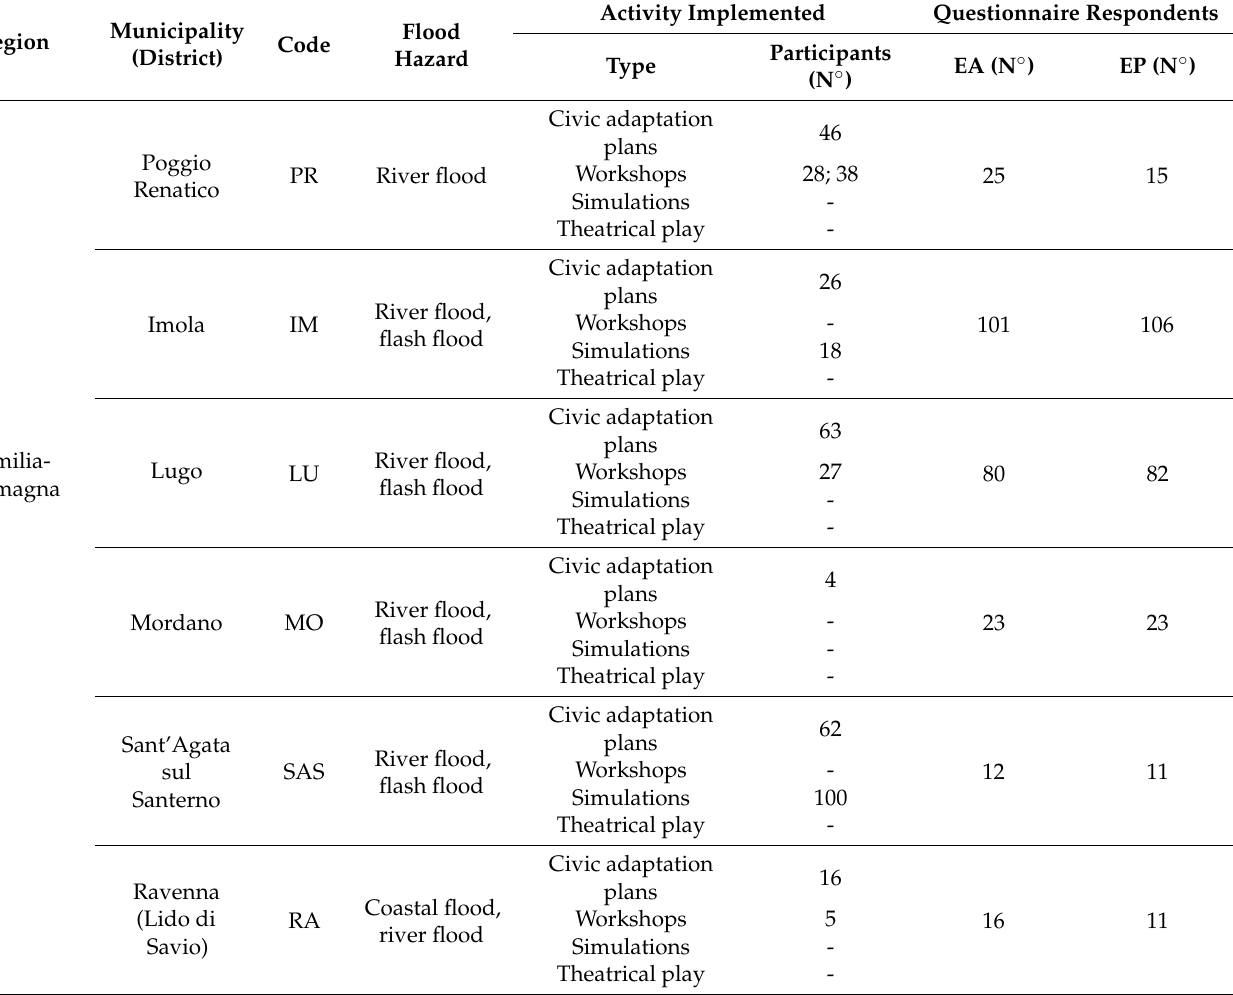
Table 1. List of the study areas identified by region, municipality (district), and code. Each site has been linked to the most impacting type of floods, activities implemented by the project, and number of survey respondents. The types of floods are listed in order of importance. The implemented flood risk reduction activities are listed per type (i.e., civic adaptation plans, workshops, alert simulations, theatrical plays) and number of involved citizens. The number of spectators in the theatrical play are estimated. The number of questionnaire respondents are divided in the ex-ante (EA) and ex-post (EP)